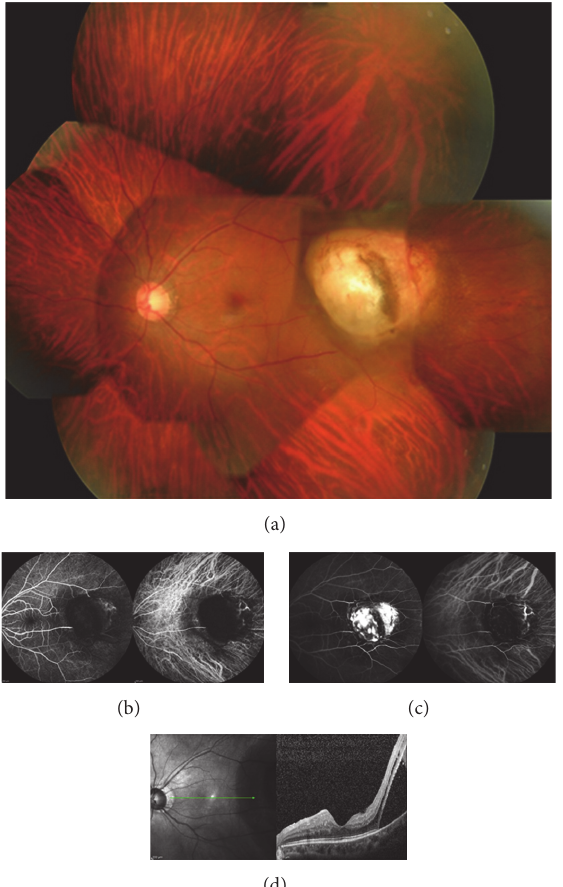
Figure 1: (a) A fundus examination revealed a yellowish dome-shaped choroidal tumor. (b) Early phase of the fluorescein (left) and indocyanine (right) angiography. (c) Late phase of the fluorescein (left) and indocyanine (right) angiography. The findings of angiographies revealed the pooling of the dye into the tumor. (d) The OCT finding of exudative retinal detachment surround the